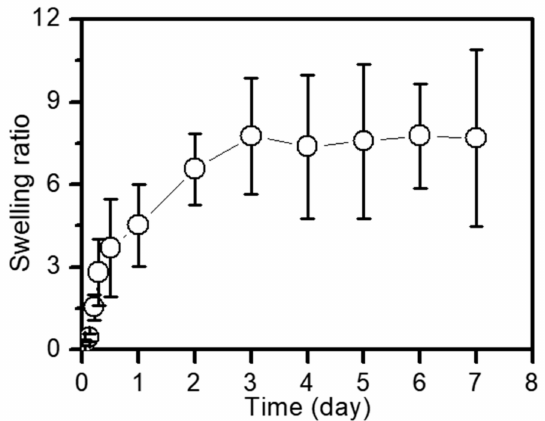
Figure 1. Swelling ratio of GDCP hydrogel measured at day 0, 1, 2, 3, 4, 5, 6, and 7. This experiment was carried out three times at 37 ◦ C. These values were expressed as the mean ± standard